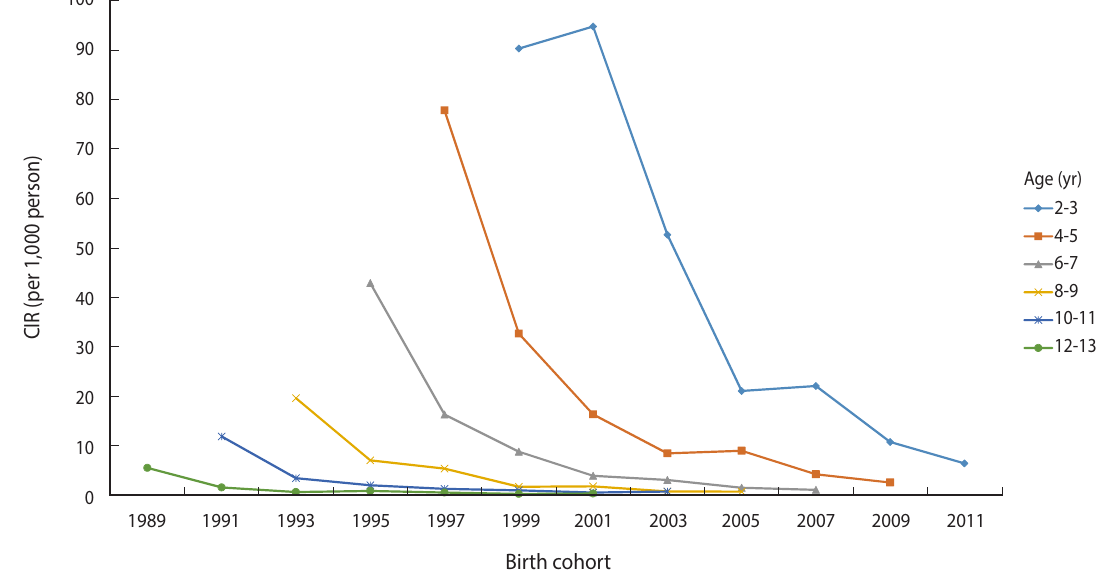
Figure 1. The birth cohort-specific crude incidence rates (CIR, per 1000 person) of varicella according to age group in children in Jeju-do, Republic of Korea.